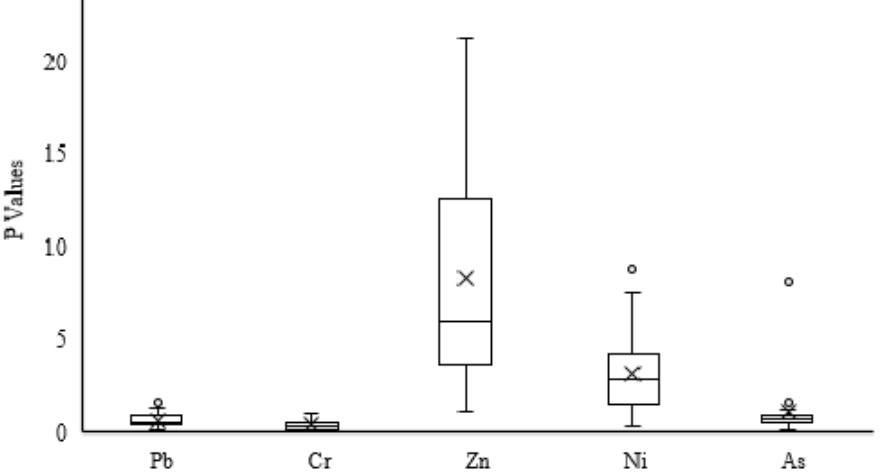
Figure 3. Boxplots of the P- values for the heavy